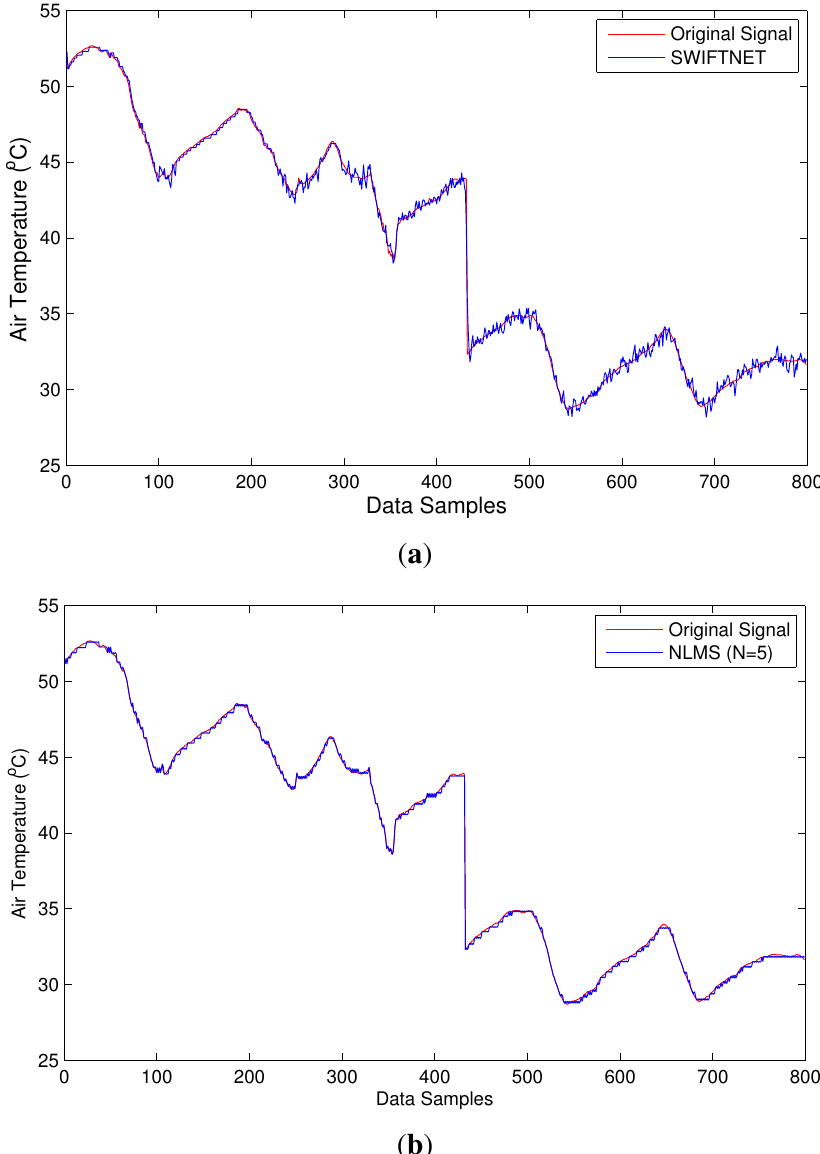
Figure 9. Signal reconstruction from Node 2, for a 2-day wildfire monitoring test-burn using a 45 ◦ C threshold cut-off point. The sparsity rate K is set to 25% at 5 min sampling interval: ( a ) Example SWIFTNET data trace. Fire is generated at different time intervals to test the efficacy of SWIFTNET to different operational mode; ( b ) Example data trace from default adaptive prediction